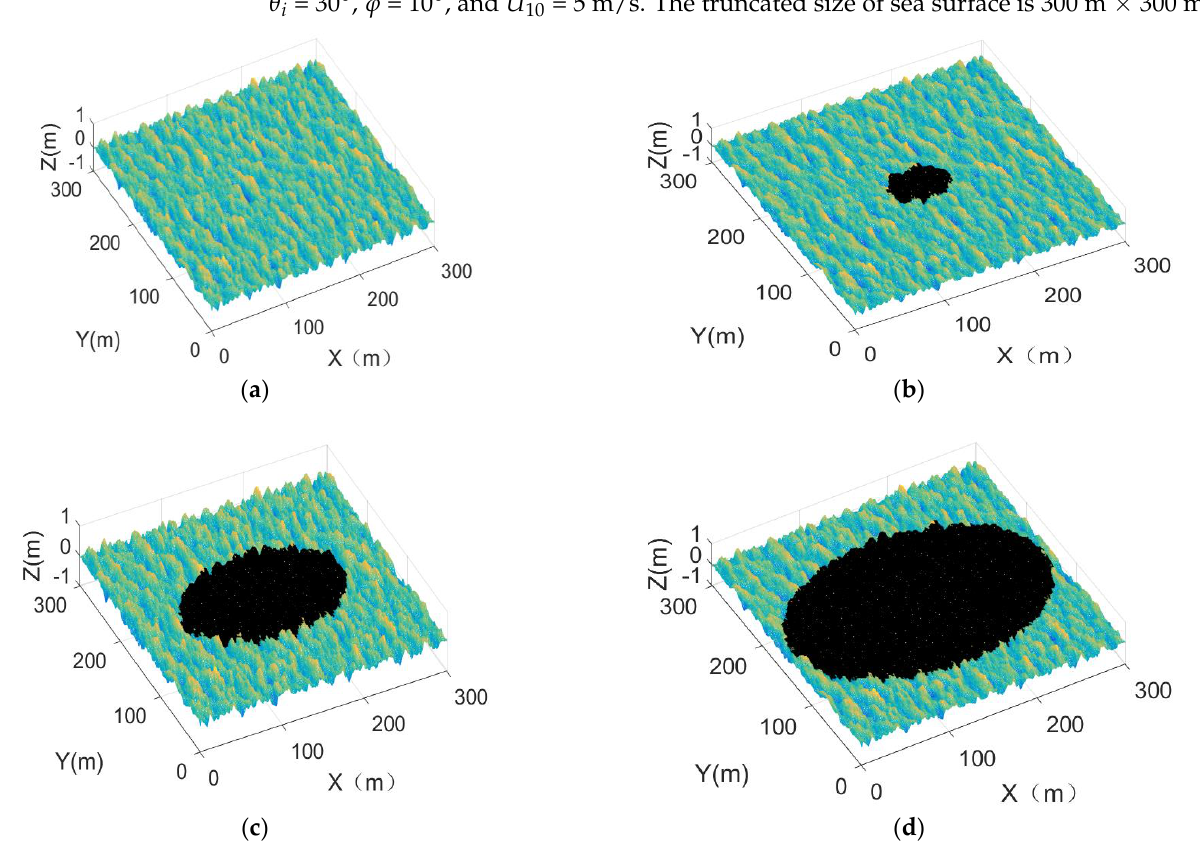
Figure 2. The 3D geometric model of oil spill−covered sea surface (the black part shows the oil spill−covered sea area). ( a ) Clean sea; ( b ) Oil spill covers 2% of the surface area; ( c ) Oil spill covers 20% of the surface area; ( d ) Oil spill covers 50% of the surface area.